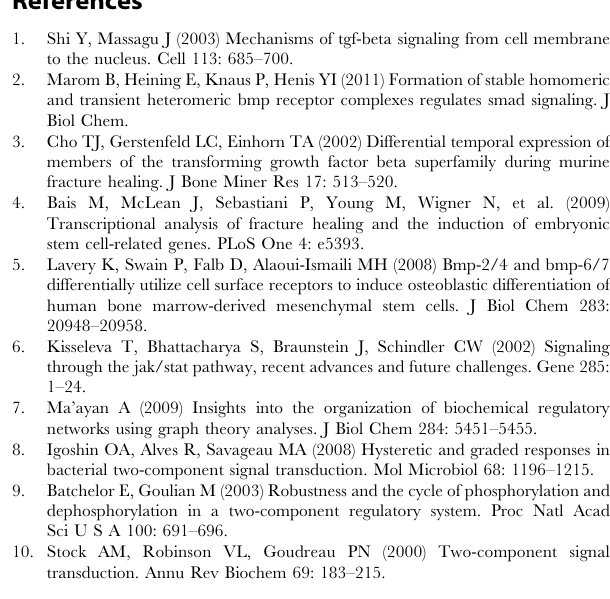
Figure S10 The Dynamic Range of the Small SMAD Model. Is of the same order of magnitude as the two-component model. Table S1 Smad Model Reactions. Table S2 Parameters and Initial Amounts for Smad Model. Table S3 Two-Component Model Reactions. Table S4 Parameters and Initial Values for Two- Component Model. Table S5 Effect of Symmetric Parameter Change. Table S6 Effect of Asymmetric Parameter Change. Table S7 Model 1 Information and Entropy. Table S8 Parameters and Initial Values for Large Dynamic Range Two-Component